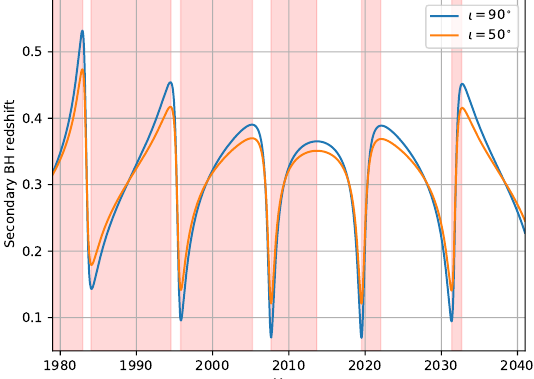
Figure 12. The redshift of the secondary black hole as a function of time. Two inclination values are shown: 90 ◦ (edge-on) and 50 ◦ . The model does not specify the inclination. The shaded regions are the time intervals when the secondary is in front of the accretion disk and thus visible to us. The identification of the “front side” is based on taking the secondary to be in front of us during the 1989 deep fade